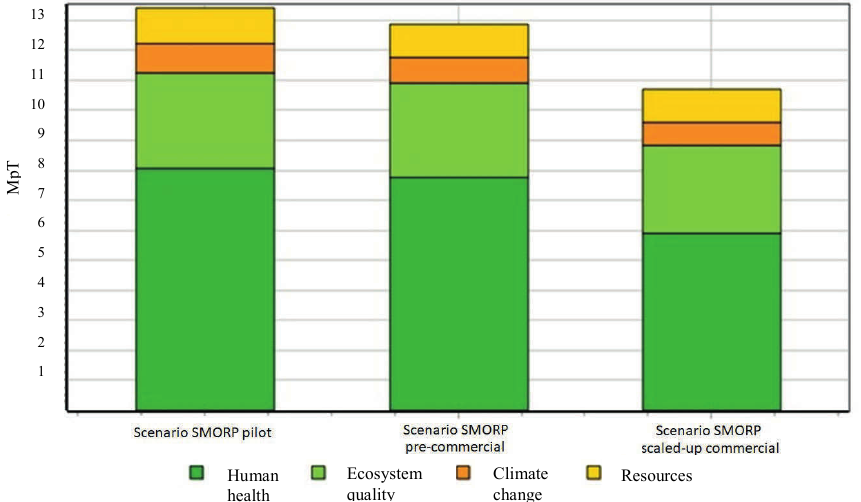
Fig. 5. Comparative LCIA results, single score comparison referred to 1